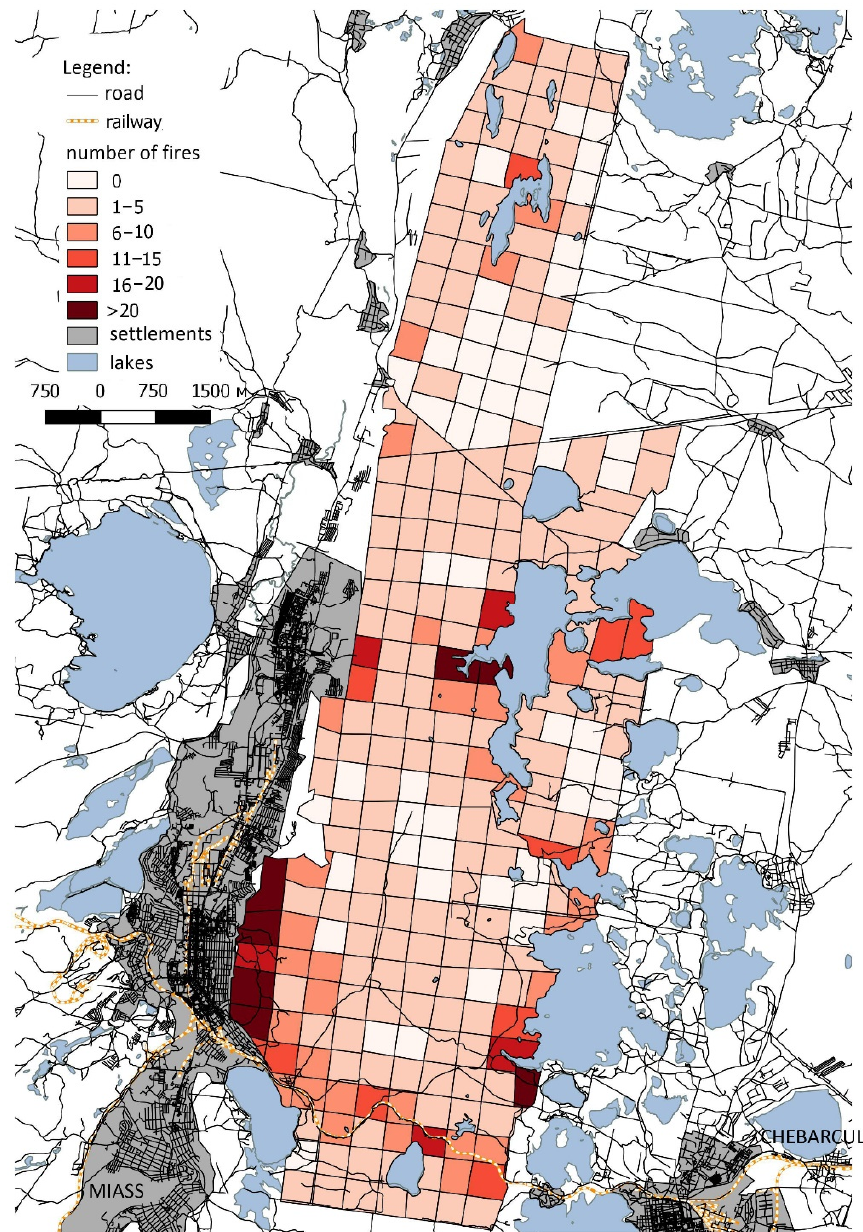
Figure 3. The spatial distribution of the total number of fires recorded in the compartments of the Ilmensky Reserve in